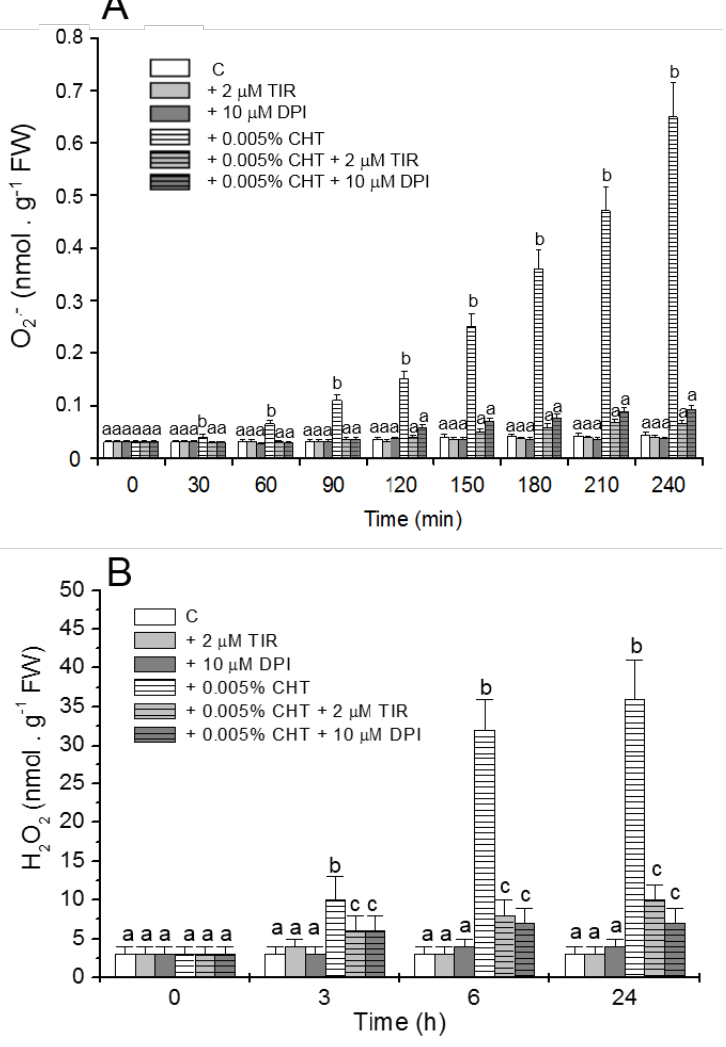
Figure 2. Effect of Tiron (TIR) and diphenylene iodonium (DPI) on the CHT-induced O 2 • − ( A ) and H 2 O 2 ( B ) accumulations in the culture medium . At the indicated times aliquots of culture medium were collected and O 2 • − and H 2 O 2 content was measured. Mean values ± SD ( n ≥ 9) are presented. Different letters indicate significant differences among treatments at each experimental time (Tukey HSD test, p ≤